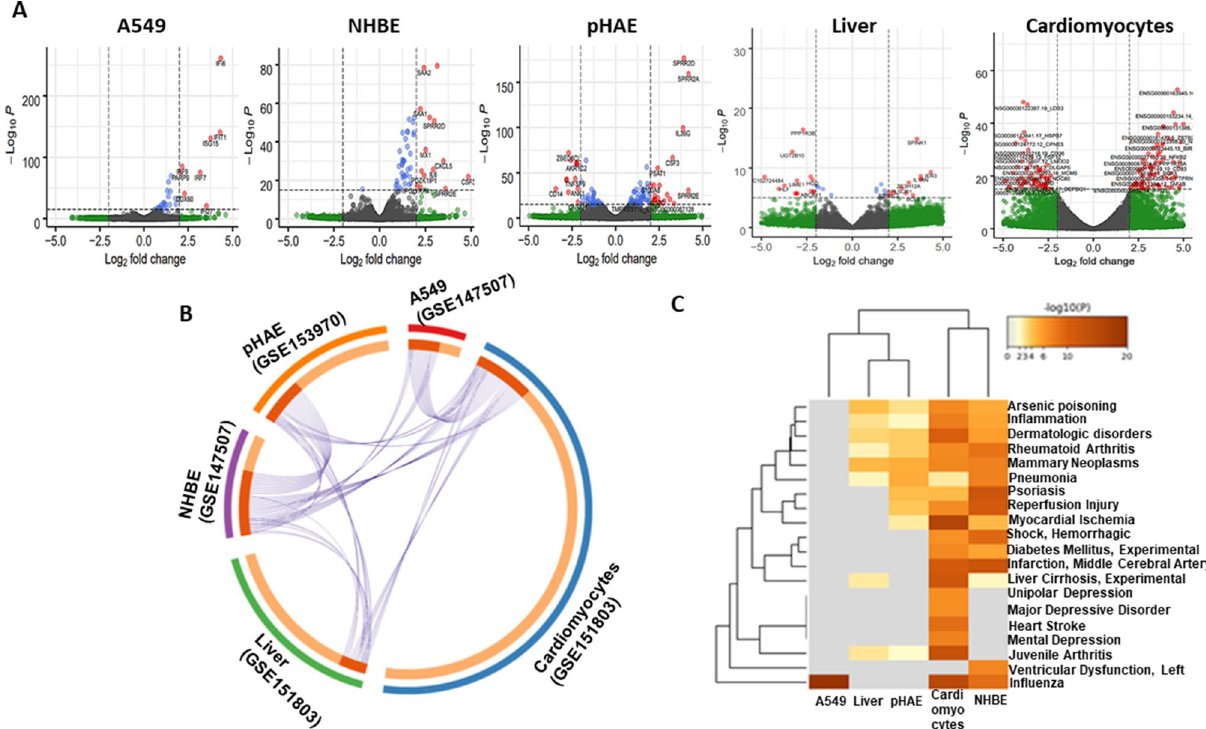
Figure 1. DEGs of SARS-CoV-2 infection. ( A ) Volcano plots indicating DEGs of A549, NHBE, pHAE, Liver organoids and Cardiomyocytes upon SARS-CoV-2 infection for 24 h. DEGs (p-adjusted < 0.05) with a log2FC of more than 2 are indicated in red. Non-significant DEGs with a log2FC of more than 2 are indicated in green. ( B ) Circos plot showing overlapping among the genes significantly upregulated following SARS-CoV-2 infection using purple lines. ( C ) Hierarchical clustering of the top most enriched diseases by the upregulated genes from different datasets. Dendogram is colored by the p values where grey cells indicate the lack of significant